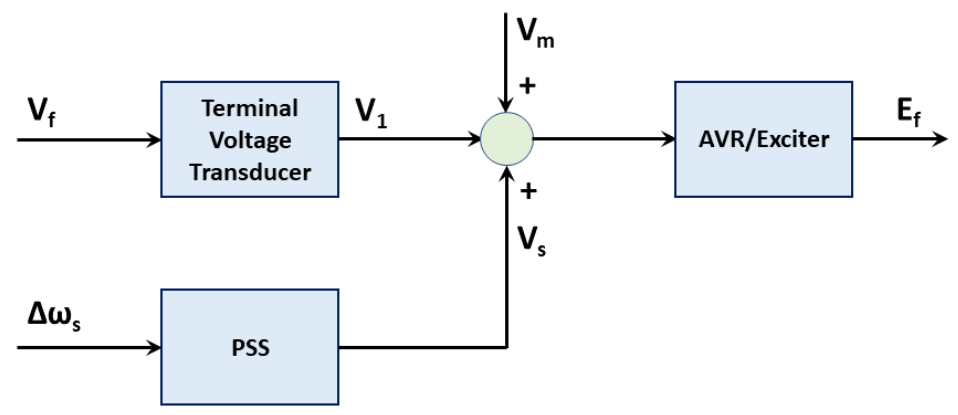
Figure 2. AVR + PSS controller diagram block.